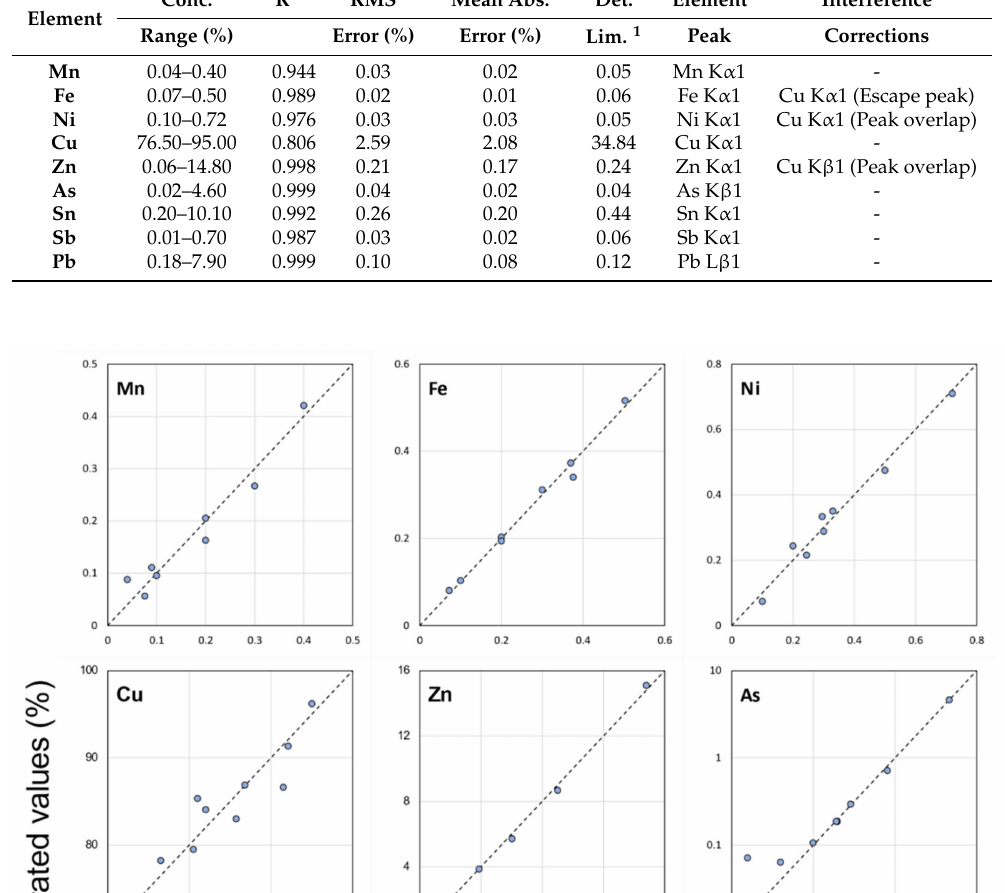
Table A2. Calibration parameters. 1 Detection limit calculated as 3.3 × ( σ /S). Element